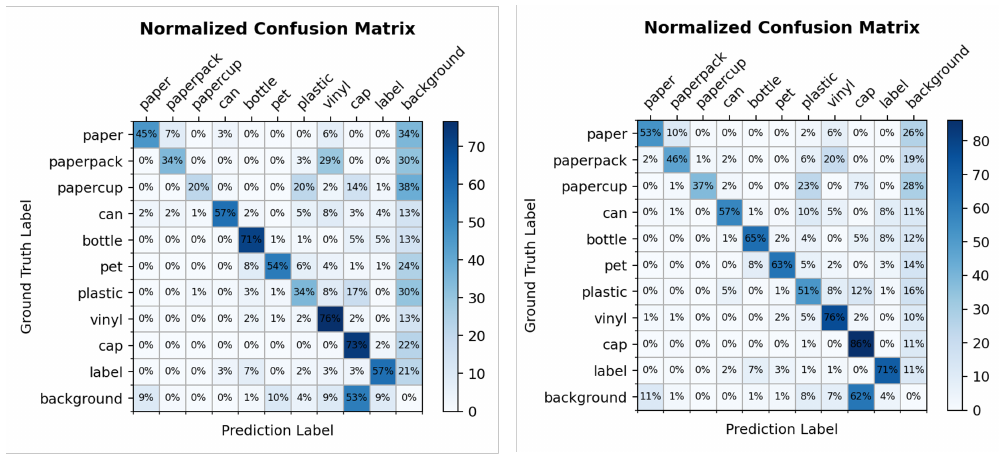
Figure 8. Confusion matrix of ARTD-Net1 and ARTD-Net2.